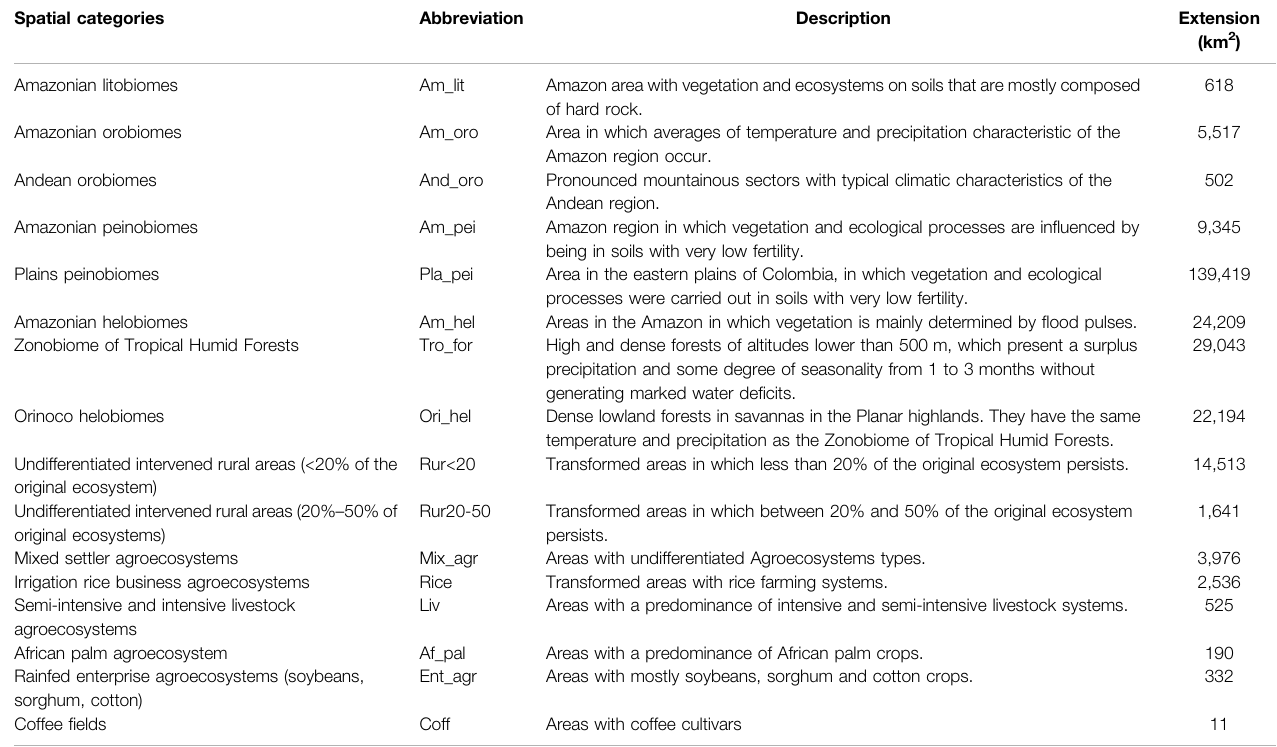
TABLE 1 | Natural biomes and transformed ecosystems for the Orinoco ’ s Region and area in km 2 . Descriptions based on Etter (1998) and Etter et al. (2010), Etter et al.